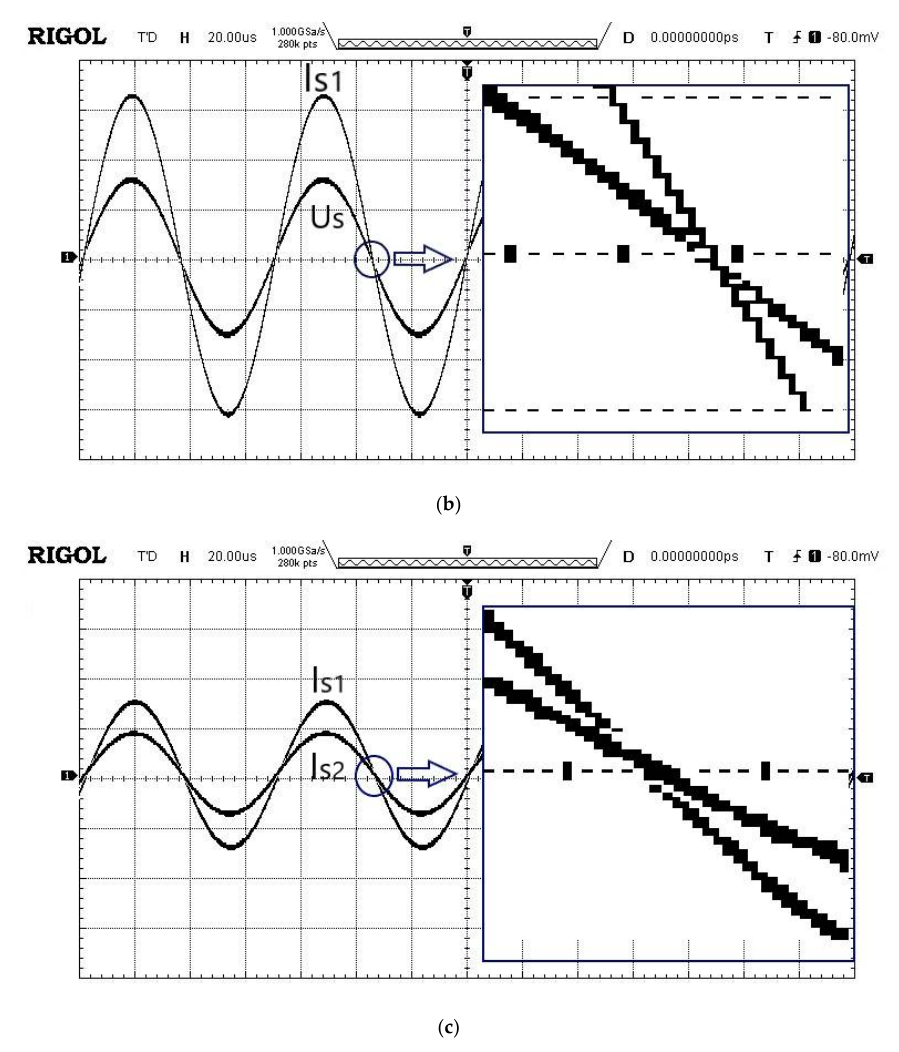
Figure 14. Waveform diagram: ( a ) Power supply voltage U s and secondary side load current I s of SISO system; ( b ) Power supply voltage U s and secondary loop 1 current I s of MIMO system; ( c ) Secondary side current I s 1 and I s 2 of MIMO system.